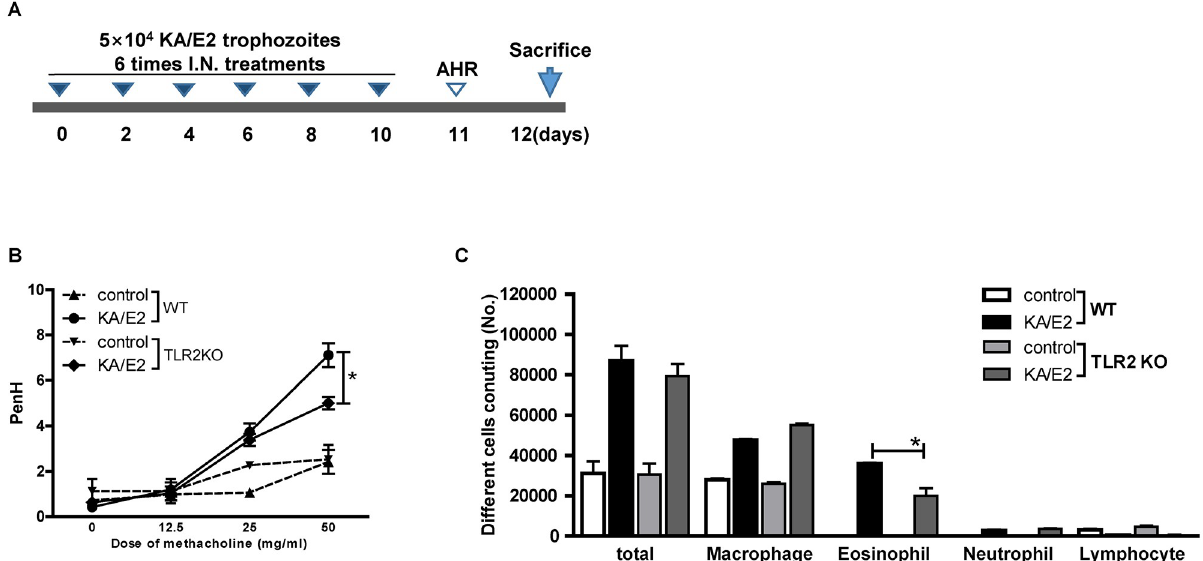
Fig 2. KA/E2 induced allergic airway inflammation via TLR2. Lung inflammation was induced via intranasal inoculation of 4x10 5 KA/E2 trophozoites (A). Airway resistance values in response to methacholine (0 to 50 mg/ml) were compared between WT and TLR2 KO mice treated with KA/E2 (B). Differential inflammatory cells were counted in BAL from WT or TLR2 KO mice using a microscope (C). (n = 5 mice/group, 3 independent experiments, � ; p < 0.05).